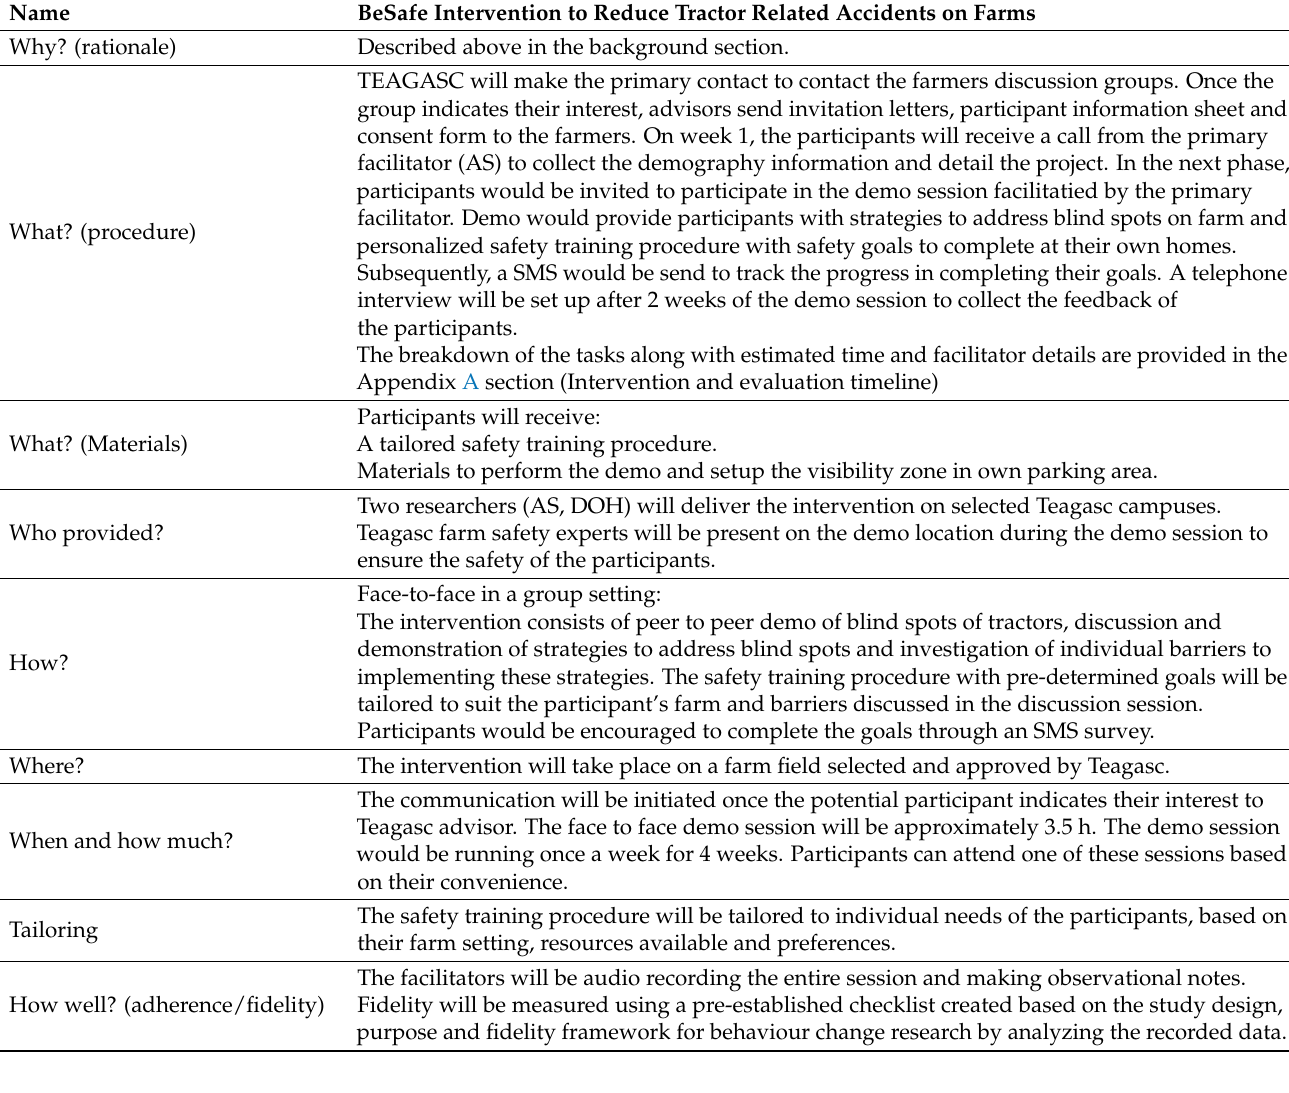
Table A5. Intervention description based on TIDieR